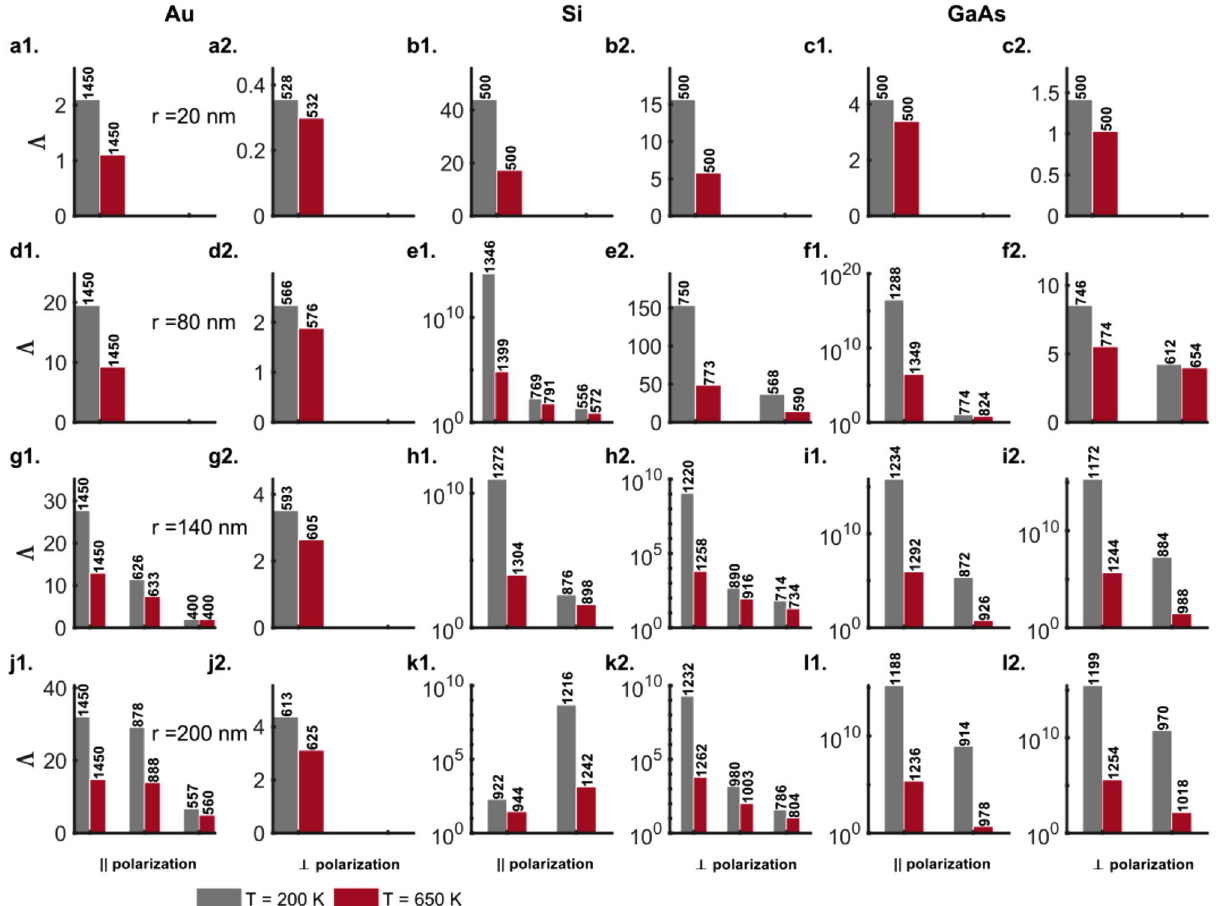
sca (cid:31) sca Figure 8. Ratio ( (cid:31) ) of scattering efficiency ( Q sca ( (cid:31) res ) ) to the absorption efficiency ( Q abs ( res ) ) as a measure of the radiative to dissipative damping for the TM ( E ) and TE ( E ) polarizations of the incident radiation for (cid:31) ⊥ ( a1 , d1 , g1 , j1 ; a2 , d2 , g2 , j2 ) Au (DL model), ( b1 , e1 , h1 , k1 ; b2 , e2 , h2 , k2 ) Si and ( c1 , f1 , i1 , l1 ; c2 , f2 , i2 , l2 ) 200 (grey bars) and 650 20, 80, 140 and 200 nm , respectively, at temperatures T GaAs nanowires of radii r = = (maroon bars) K . The numbers on top of the bars indicate either the wavelengths (in nm ) at which the scattering resonances occur or the maxima in scattering efficiency in the wavelength range under consideration in the case of the thin ( 20nm ) wires. Here, the Mie computations for the nanowires of different sizes take into account their thermal expansion, although the text labels indicate the values for nanowire radii at 200 K